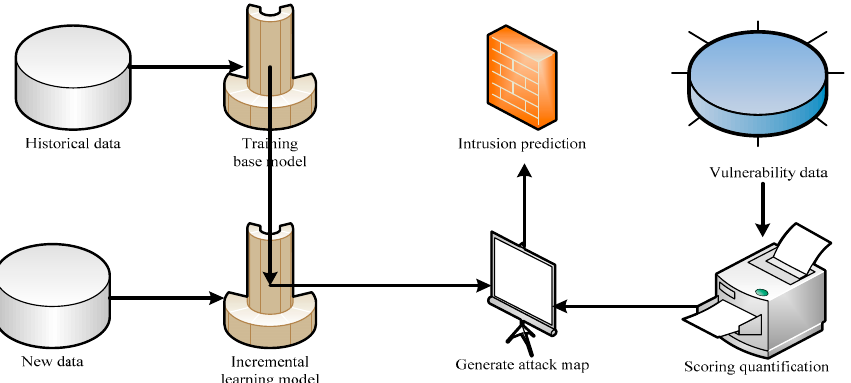
Figure 2. A Framework for the Combination of Bayesian Attack Graph and IL Intrusion Detection Method.